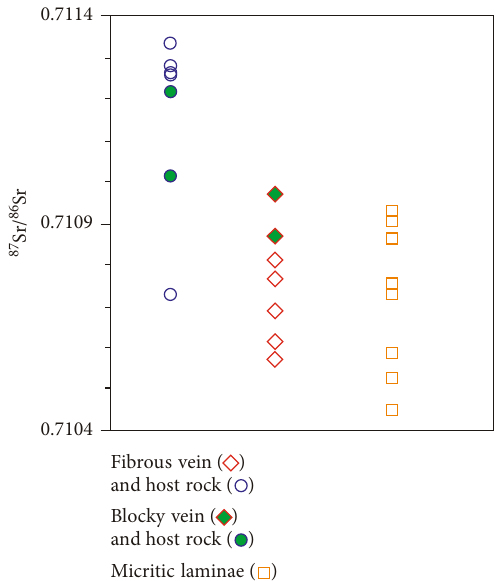
Figure 14: Strontium isotopic composition of micritic carbonate laminae, calcite veins, and host